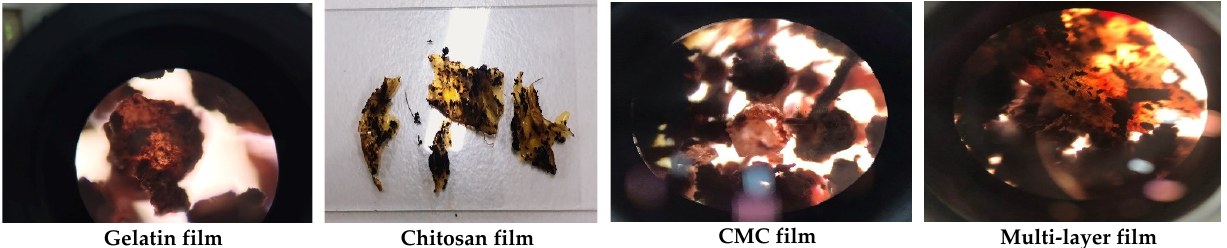
Figure 5. Photographs of disintegrated monolayer gelatin, chitosan and CMC films and multi-layered film observed under an optical microscope.